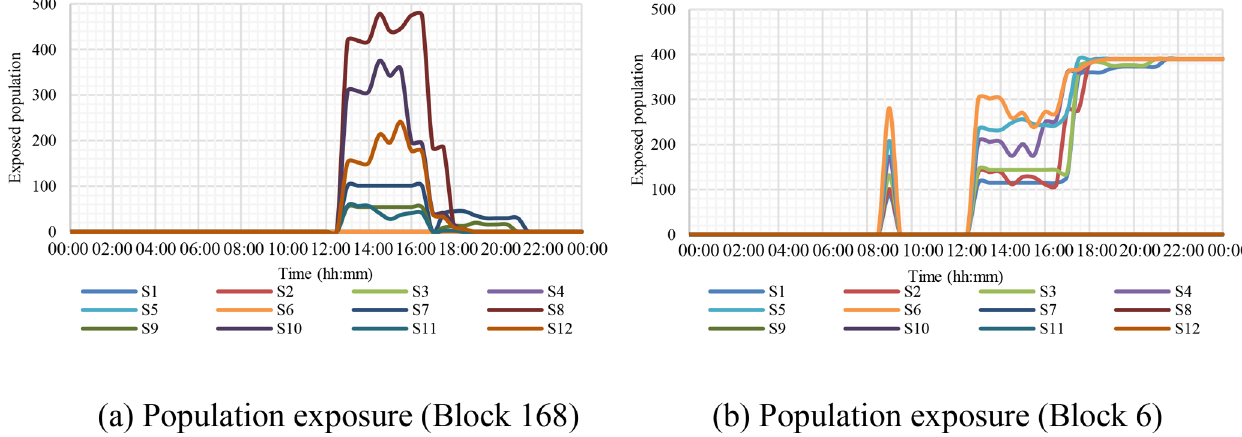
Figure 14. Changes in the population exposure of two blocks for the 12 scenarios. Block 168 was a recreational area, and Block 6 was a residential area.